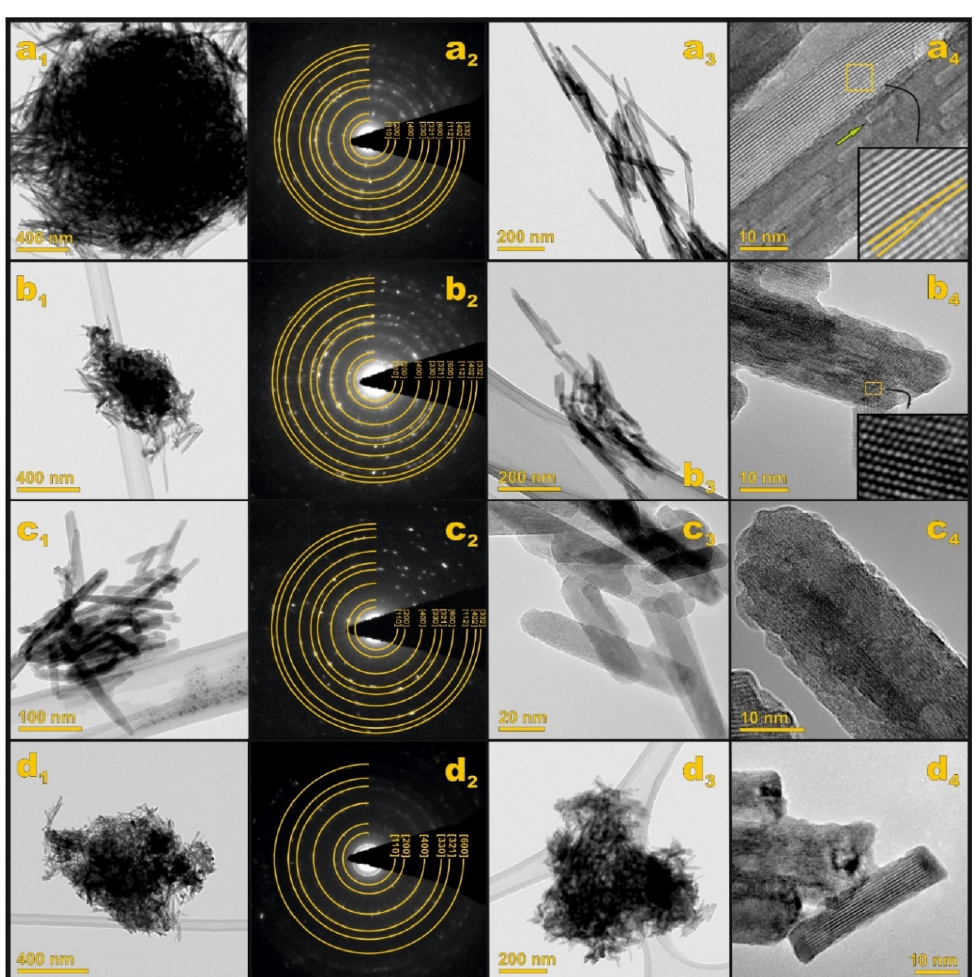
Figure 2. Conventional BF TEM imaging of K-OMS-2 nanorods ( a 1 ) supplemented by the SAED analysis of the sample phase/crystallinity ( a 2 ) and HR TEM imaging of the sample structure ( a 3 , a 4 ). The corresponding analysis was performed for niobium-doped cryptomelane nanorods (Nb/K-OMS- 2): 3 wt% Nb ( b 1 – b 4 ), 7 wt% Nb ( c 1 – c 4 ), 23 wt% Nb ( d 1 – d 4 ), respectively.